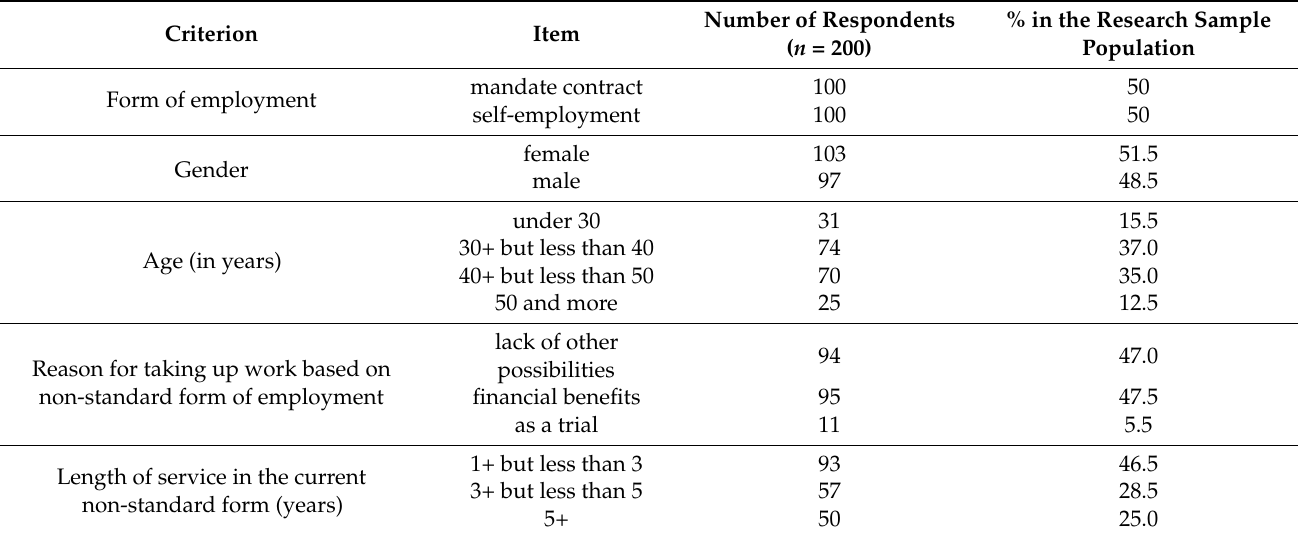
Table 2. Characteristics of the research